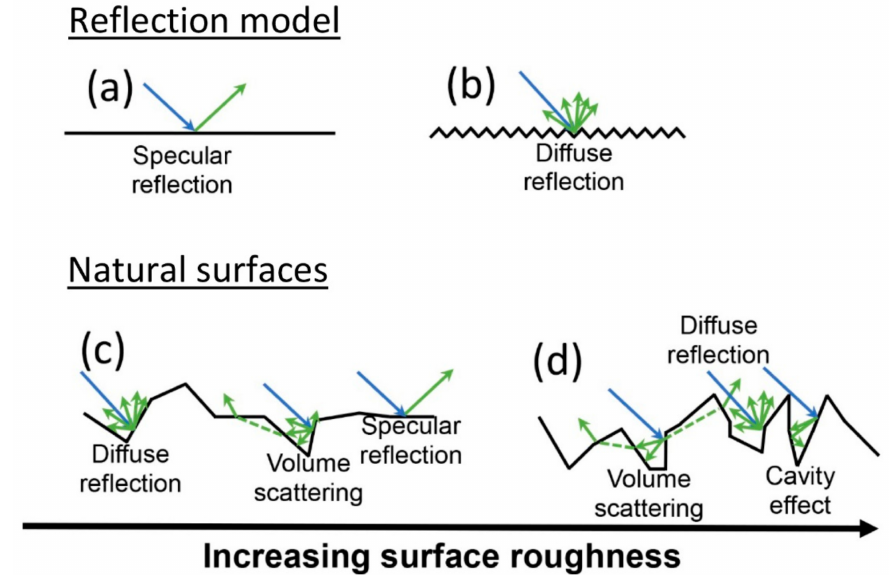
Figure 1. Schematic diagram of interaction of light with a smooth surface ( a ) that displays specular reflection and a rough surface ( b ) that displays diffuse reflection. In natural surfaces, increasing surface roughness decreases specular reflection ( c ) and promotes diffuse reflection, volume scattering, and the cavity effect ( d ), which all reduce the spectral